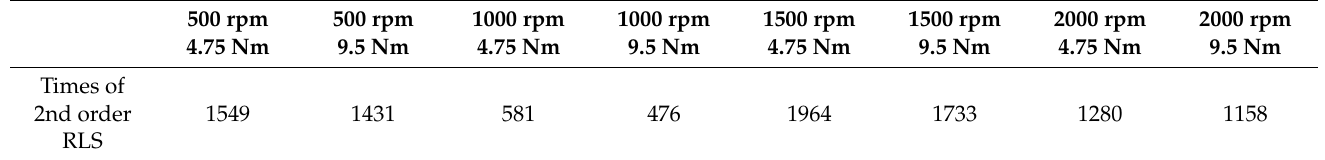
Table 6. Required RLS iteration times by using modified value of L d 0 .